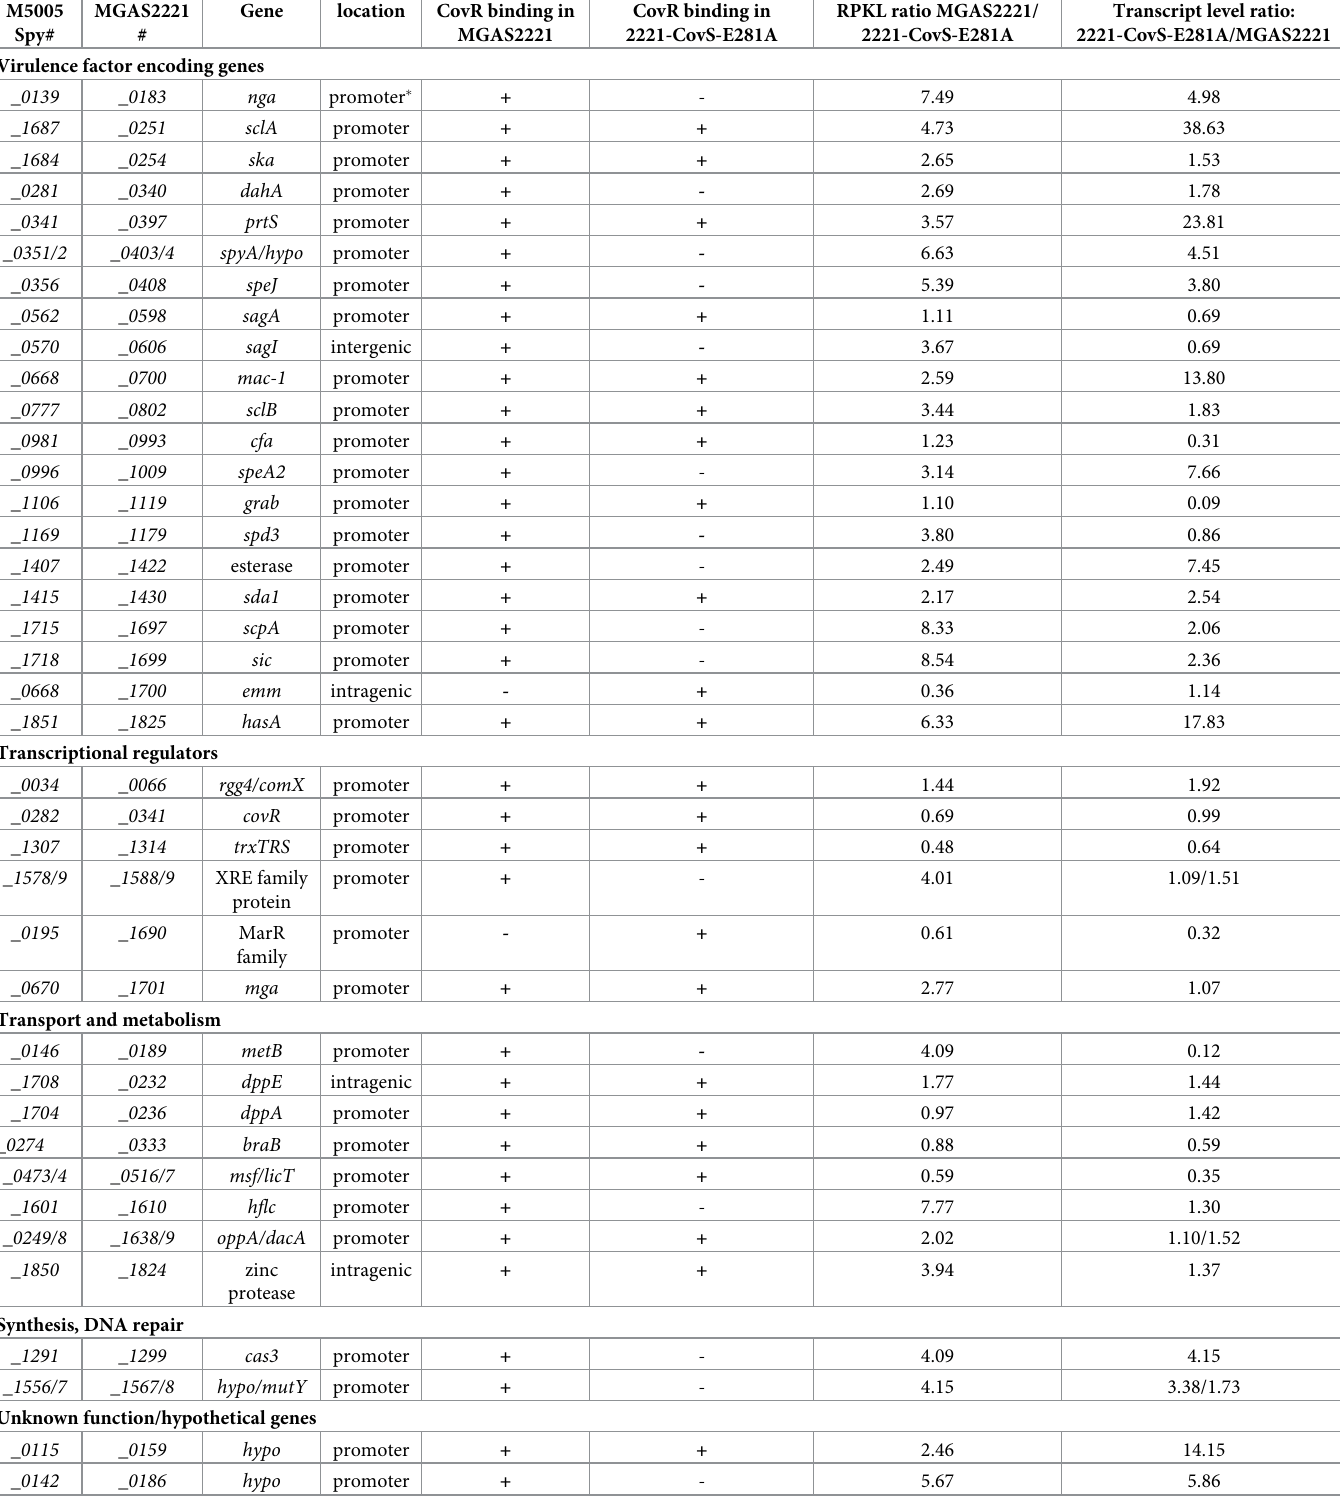
Table 2. Peaks at genes belonging to CovR